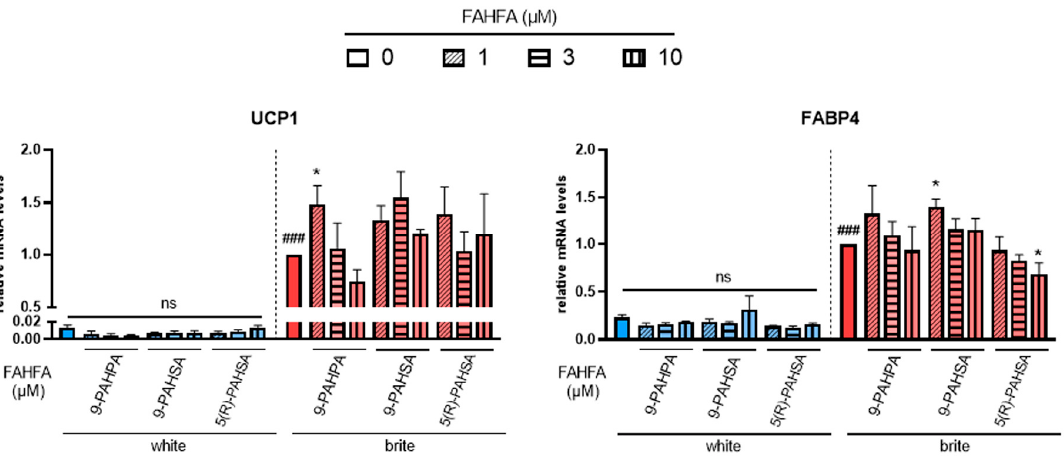
Figure 1. Effects of FAHFA on UCP1 mRNA expression. White hMADS adipocytes (blue columns) were converted (from day 14 to day 18) into brite adipocytes (red columns) using the PPAR γ agonist rosiglitazone in the absence (empty) or the presence of 1, 3 or 10 µM (shades) 9-PAHSA, 9-PAHPA and 5(R)-PAHSA. mRNA levels of UCP1 and FABP4 markers were measured. Histograms display mean ± SEM of three to five independent experiments; statistics were conducted through a one-way ANOVA with Dunett’s multiple comparisons test, where p < 0.05 was considered significant: ###: p < 0.001, white vs. brite adipocyte; *: p < 0.05, treated vs. untreated white or brite adipocytes.